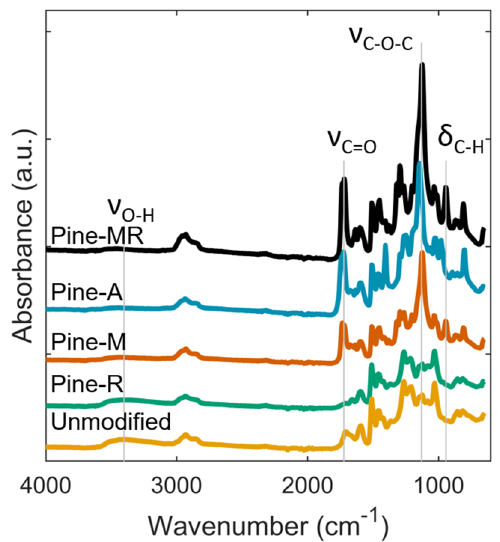
Figure 1. FTIR spectra for pine lignin before and after each modification. MR—reduction plus methacrylate modification, A—acrylate modification, M—methacrylate modification, and